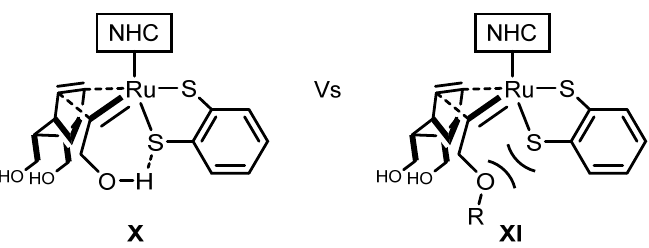
Figure 10. Different reactivity observed between allylic alcohols and allylic ethers believed to be a product of electron density buildup on the sulfur atom trans to the N -heterocyclic carbene (NHC).